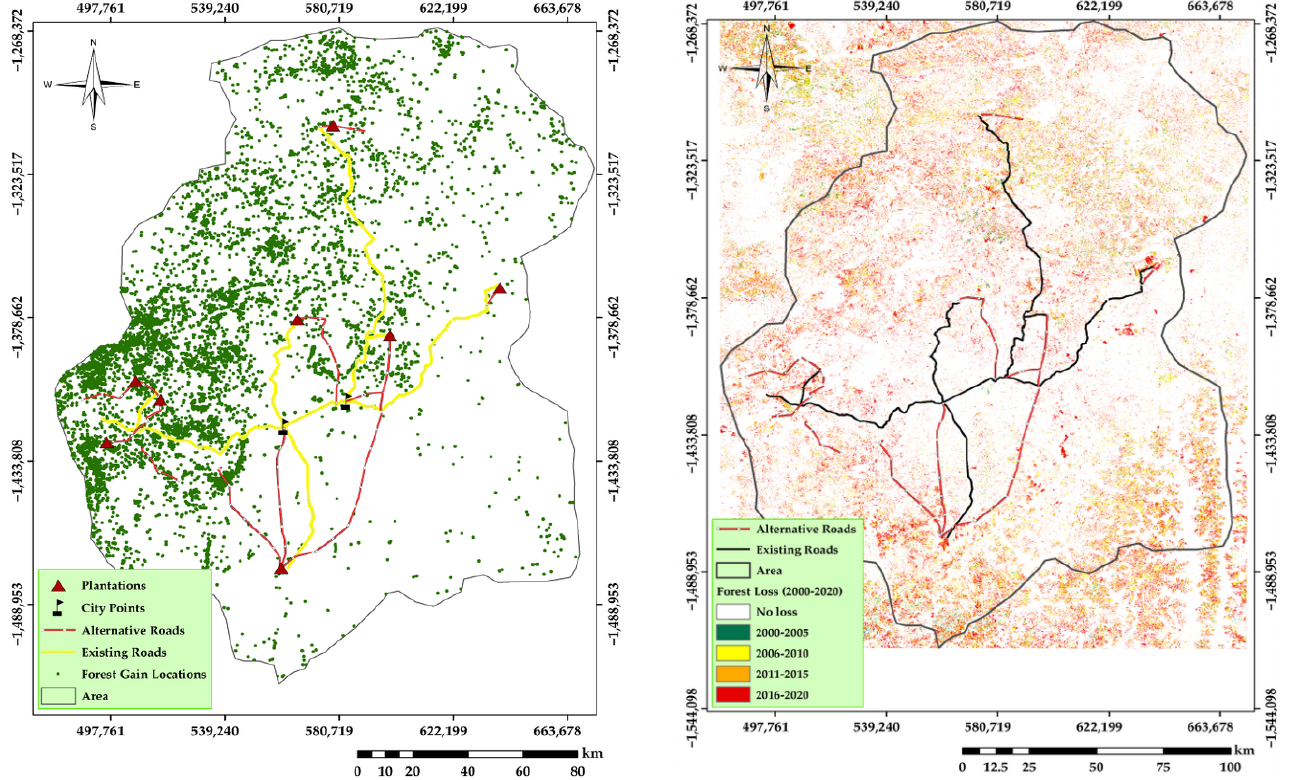
Figure 12. Forest gain and forest loss in relation to new alternatives roads.